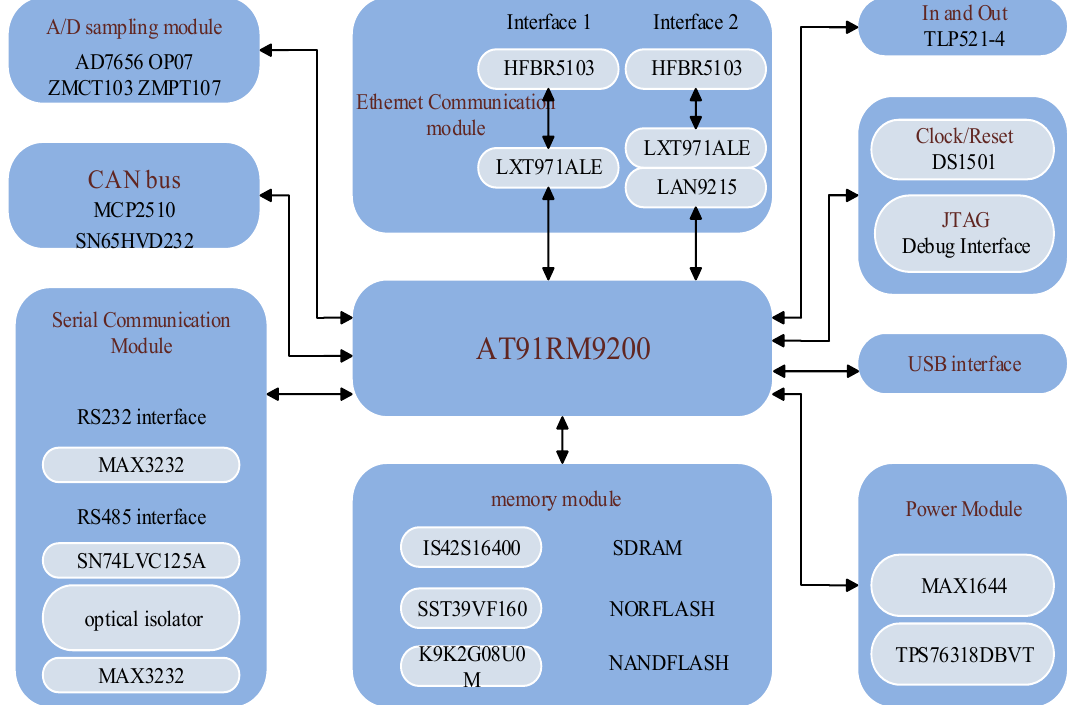
Figure A6. Hardware platform of ECP